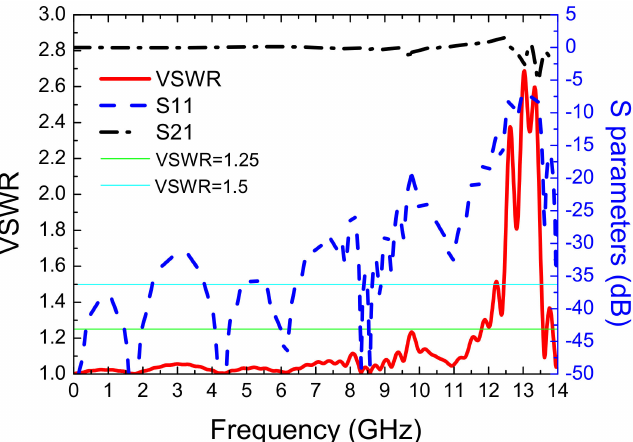
Figure 17. S-parameters and VSWR simulation results of the scaled-down IC-Stripline cell based on image theory. S33 is similar to S11, and S43 is similar to S21.